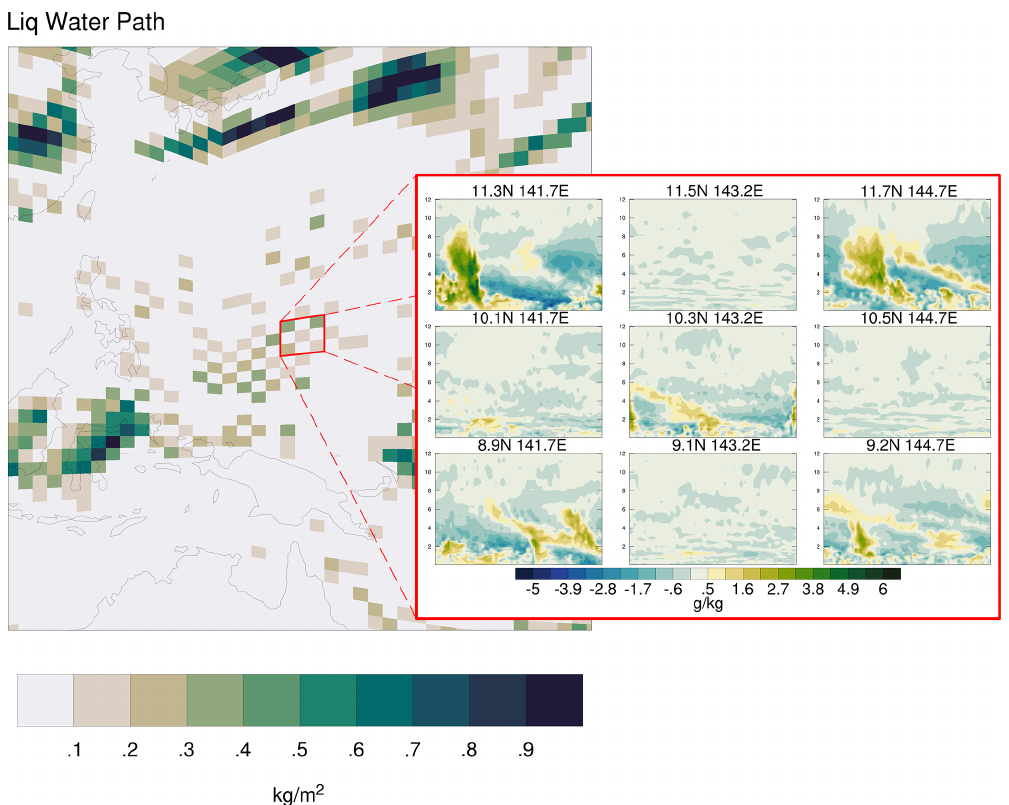
Figure 12. Instantaneous snapshot of tropical western Pacific liquid water path and CRM water vapor field for a select region exhibiting a checkerboard pattern for an arbitrarily selected day in boreal